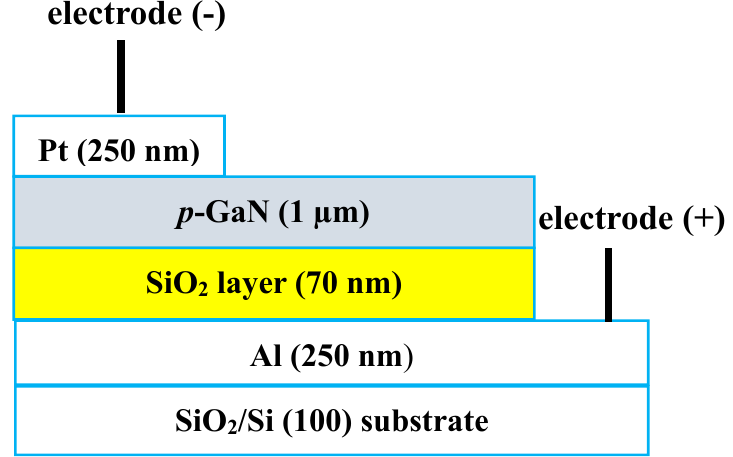
/ p -GaN MOS Schottky 2